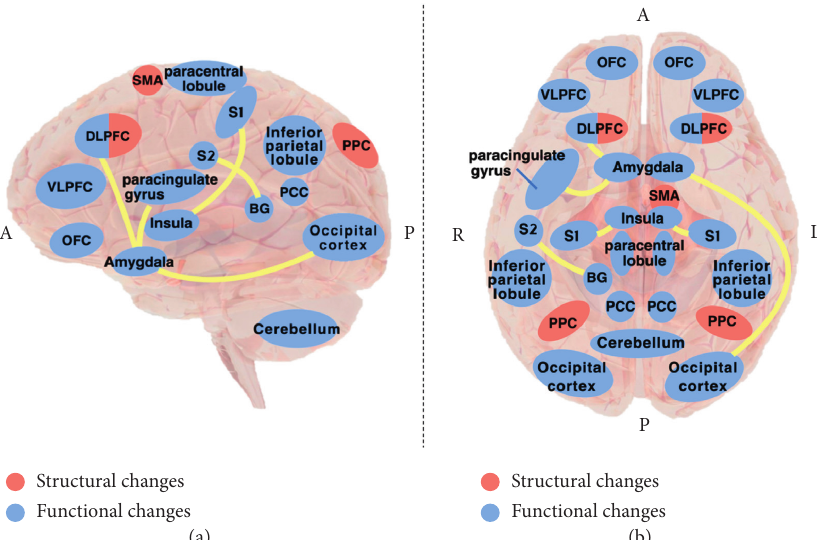
Figure 1: Illustration of the main mechanisms of CBT in pain management. (a) Side perspective view. (b) Bottom perspective view. Abbreviations are annotated after Table